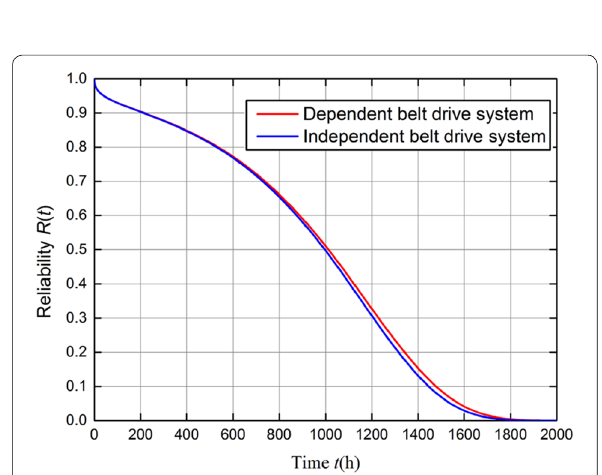
Figure 10 Reliability of the belt drive system